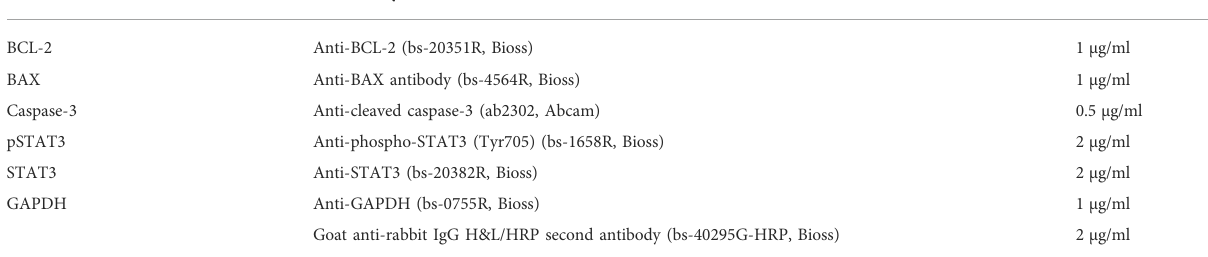
TABLE 1 Antibodies used in western